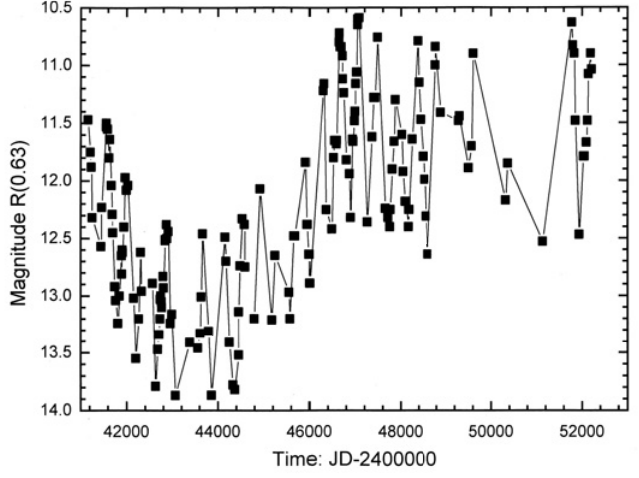
Fig. 1. Observed light curve of V1558 Cyg.